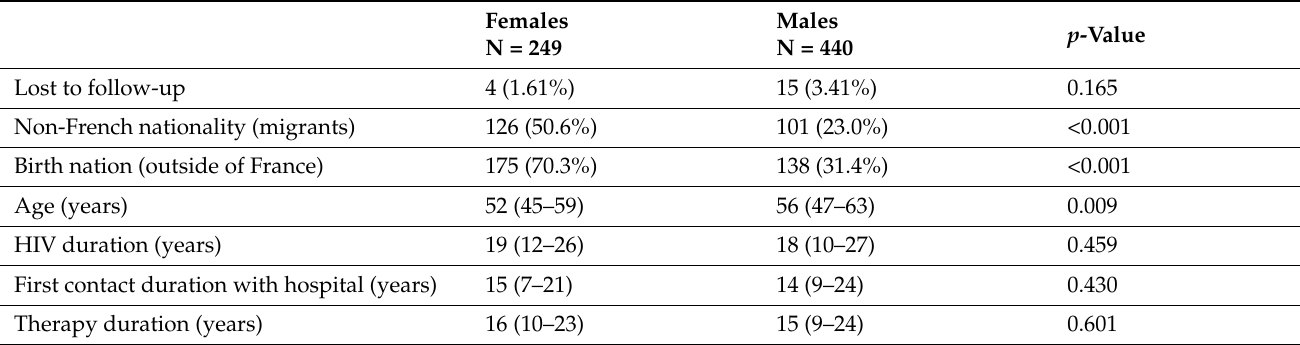
Table 2. Characteristics of females and males of the study